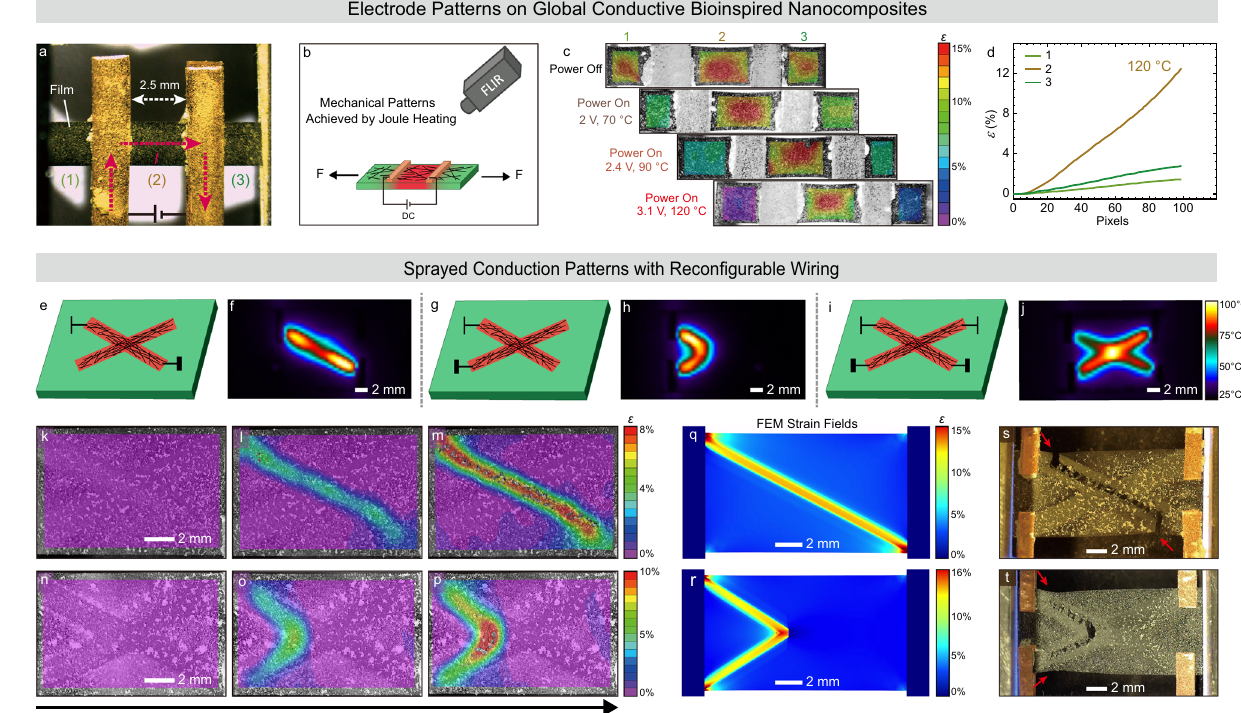
Fig. 4 Electricity-adaptive mechanical patterns under applied voltage. a – d Mechanical patterns achieved on a global conductive CNF/EG-UPy 29 /SWNT (50/50/10) nanocomposites by changing the heating zone. a Photograph for the mechanical patterns in CNF/EG-UPy 29 /SWNT (50/50/10) nanocomposites with copper electrodes. The distance between the copper electrodes is ca. 2.5mm. The fi lms are divided into three parts, while only the central part undergoes Joule heating. b Illustration of in situ testing setup. c Strain fi elds just before fracture at different local temperatures in the middle part (with voltage input). d The true strain extracted from DIC at 120°C in the middle using DIC. The lines 1 – 3 represent the parts 1 – 3 in ( a ). e – t Mechanical patterns achieved via spray patterning conductive SWNT patterns with recon fi gurable wiring (process in Supplementary Fig. 10). Illustrations for the fi lms with SWNTs 2D patterns and selectively wiring and the corresponding FLIR images: ( e , f ) a diagonal, ( g , h ) an angle, and ( i , j ) a cross. Strain fi elds during tensile tests for differently wired patterns by applying voltage on ( k – m ) a diagonal and ( n – p ) an angle. The images in each panel are arranged from left to right for increasing global elongation, with the rightmost image just before fracture. Strain fi elds obtained using COMSOL FEM simulation by applying voltage on ( q ) a diagonal and ( r ) an angle. The corresponding crack behavior for the CNF/EG-UPy 29 (50/50) fi lms with patterned Joule heating on ( s ) a diagonal, ( t ) an